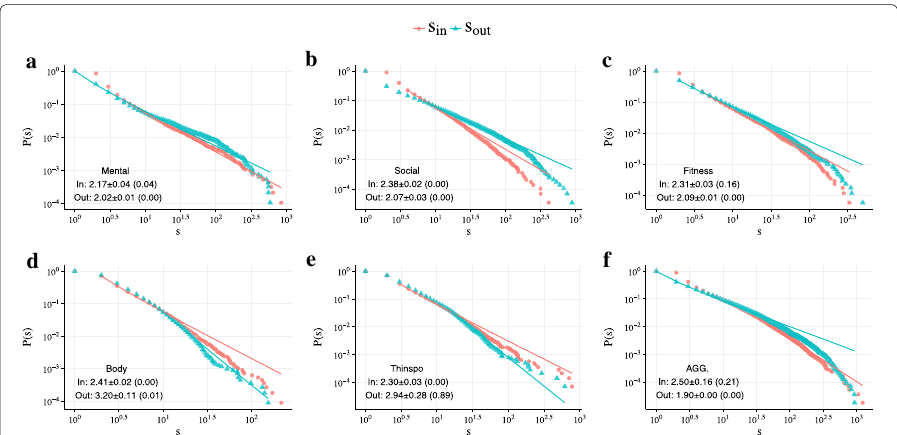
Fig. 2 Distributions of in-/out-strength ( s in / s out ) at each layer and the full aggregated network (AGG.). All values of s are shifted by 1 to account for nodes with zero values on the log-log plots. Lines fit a power-law distribution P ( s ) = s − λ using the maximum likelihood estimator and a p -value for the goodness of fit is obtained using a bootstrapping procedure (Clauset et al. 2009). The mean values and standard deviations of exponents λ are shown in the legends, and p -values obtained via 1000 bootstrap replications are reported in